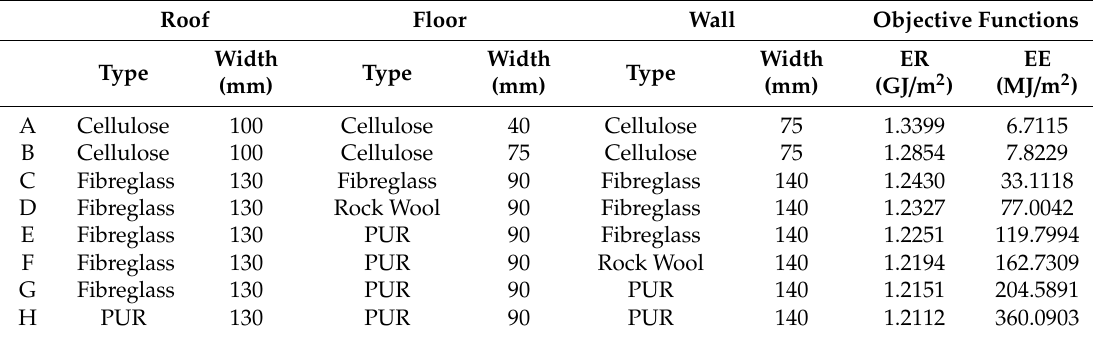
Table 5. Sample Design Solutions.